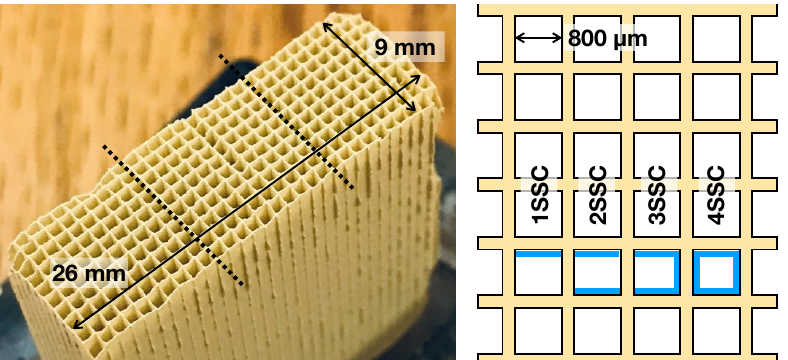
Figure 1. An image of cleaned cordierite cartridge prior to catalyst coating. The illustration shows four deposition procedures used for incremental addition of loading and the tailored distribution study. For instance, 2SSC samples had two sides with single catalyst coating depicted in